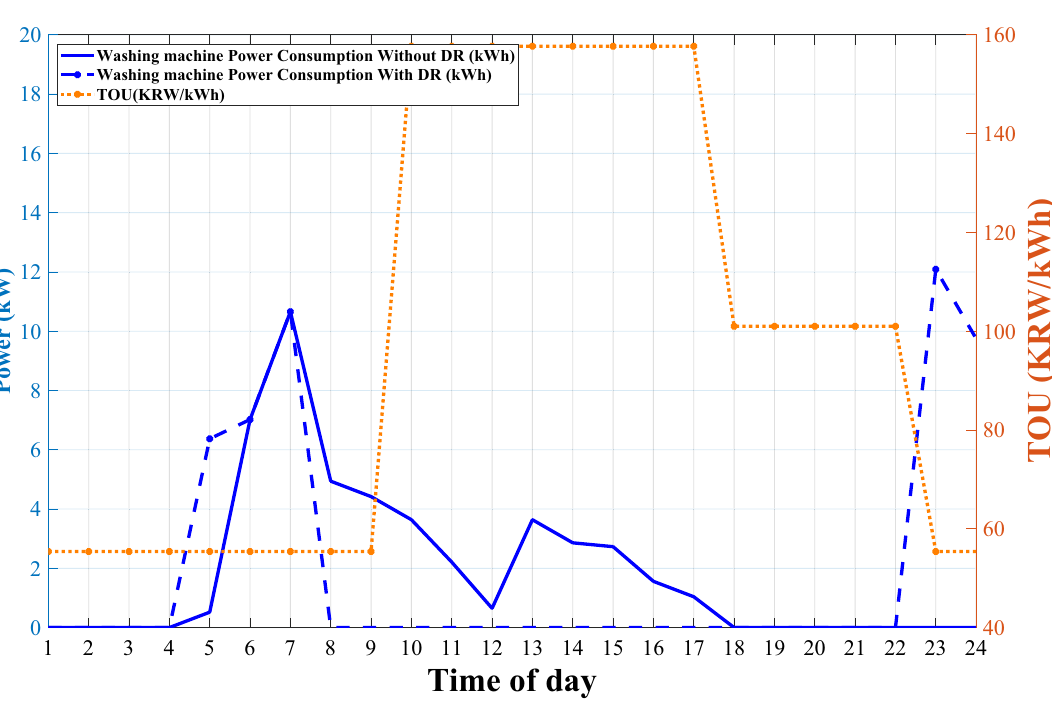
Figure 9. Washing machine power consumption with and without